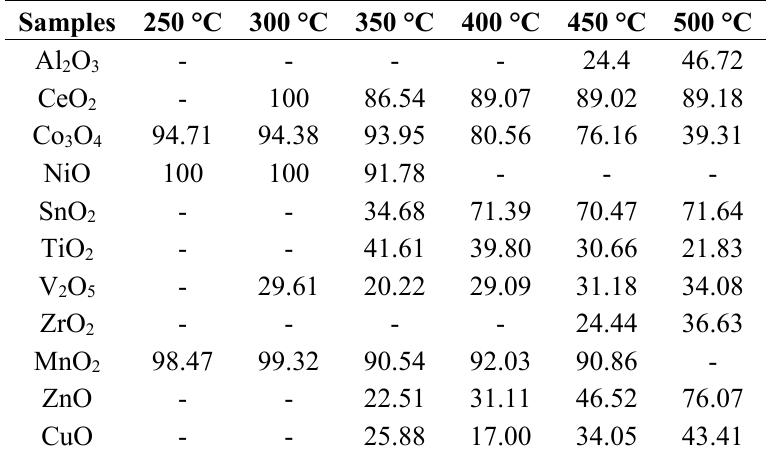
Table 2. CO 2 selectivity (%) of some metal oxides at different reaction